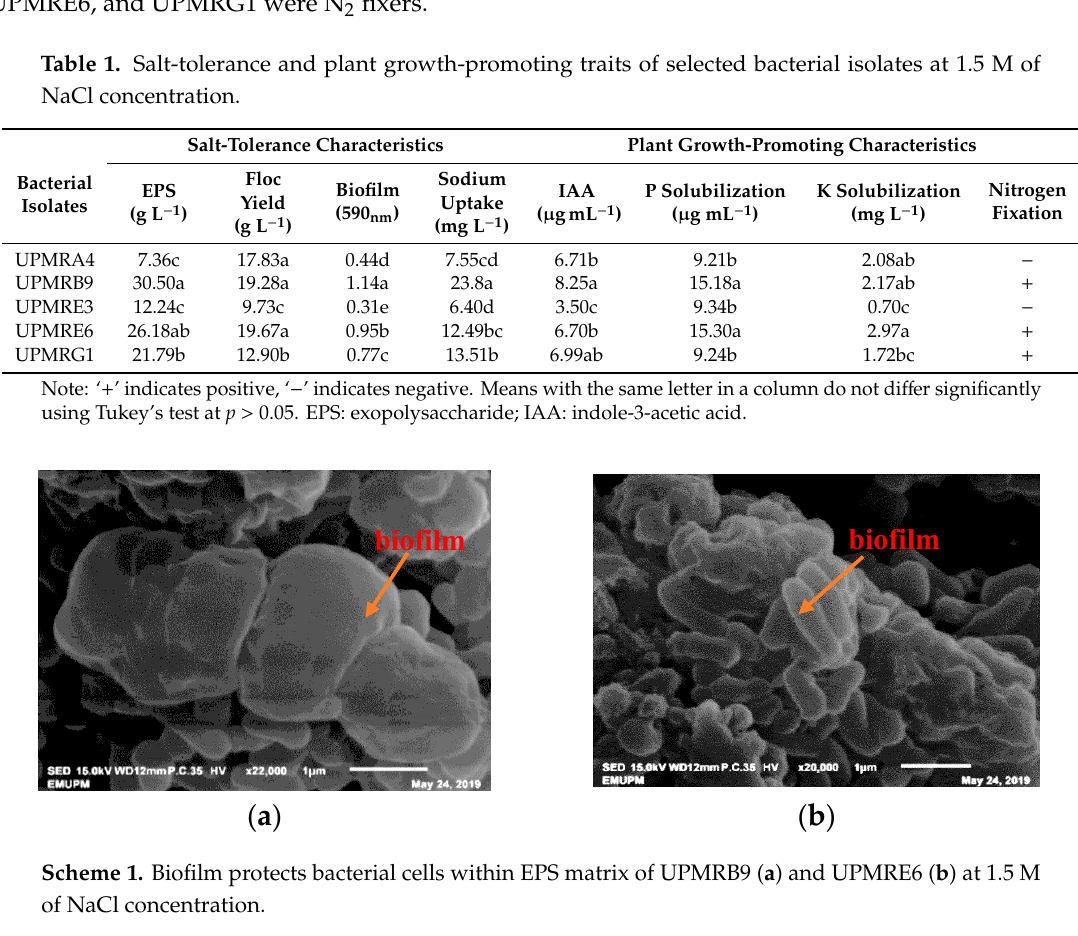
Table 1. Salt-tolerance and plant growth-promoting traits of selected bacterial isolates at 1.5 M of NaCl concentration.